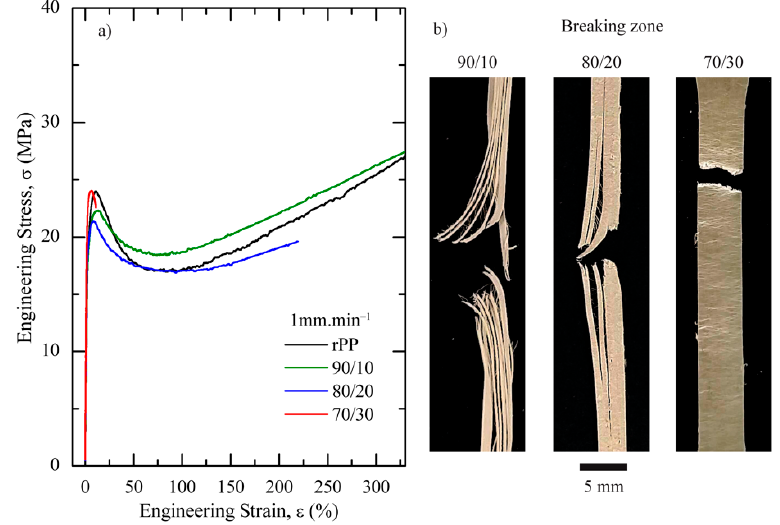
Figure 6. Effect of the rPET-O content on the mechanical properties of rPP/rPET-O sheets: ( a ) repre- sentative engineering stress–strain curves and ( b ) visual aspect of the fracture zone.